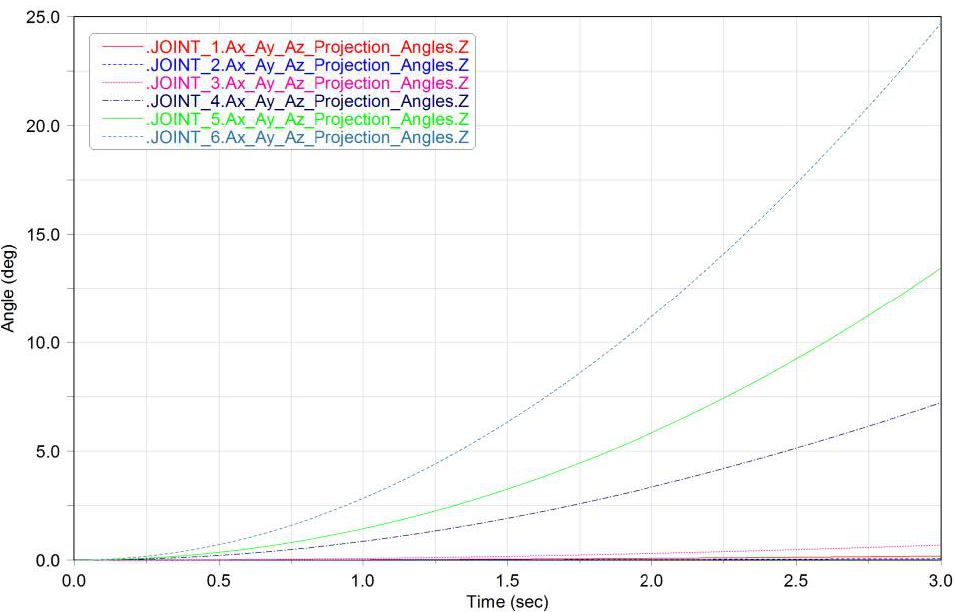
Figure 6. Diagram of the rotation angle of each joint over time (ADAMS).